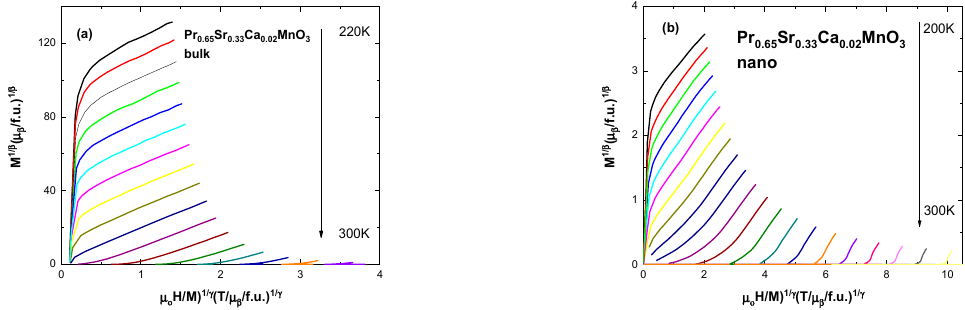
Figure 8. Modified Arrott plots for ( a ) the bulk sample x = 0.02 with β = 0.212, γ = 1.057, δ = 5.986 and for ( b ) the nanocrystalline sample x = 0.02 with β = 0.541, γ = 1.01, δ = 2.867. Table 5. Critical exponent values for all samples from modified Arott plot Remarkably, polycrystalline samples are more closely governed by tricritical mean field model ( β = 0.212, γ = 1.057, δ = 5.986 for x = 0.02), rather than 3D Heisenberg model